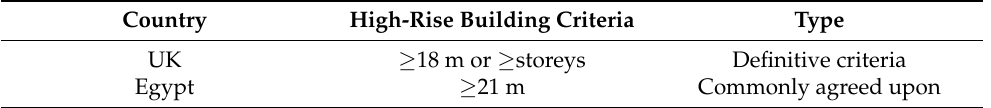
Table 1. Comparison of High-Rise Building Definitions.